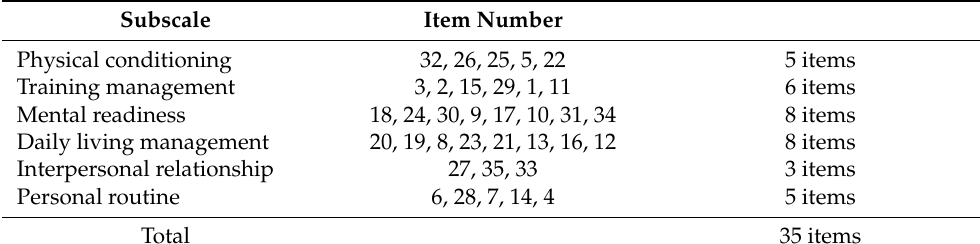
Table 3. Athletes’ Self-Management Questionnaire (ASMQ).